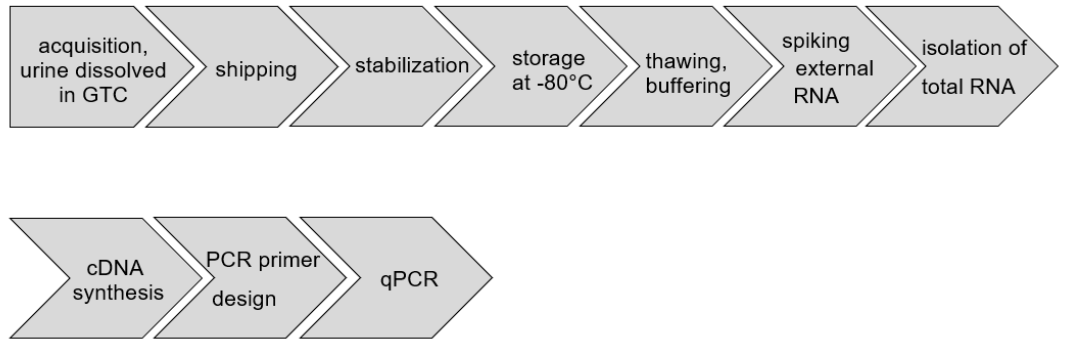
Figure 1. Standardized processes for acquisition, shipping, treatment, and RT-qPCR-based analysis of urine RNA.